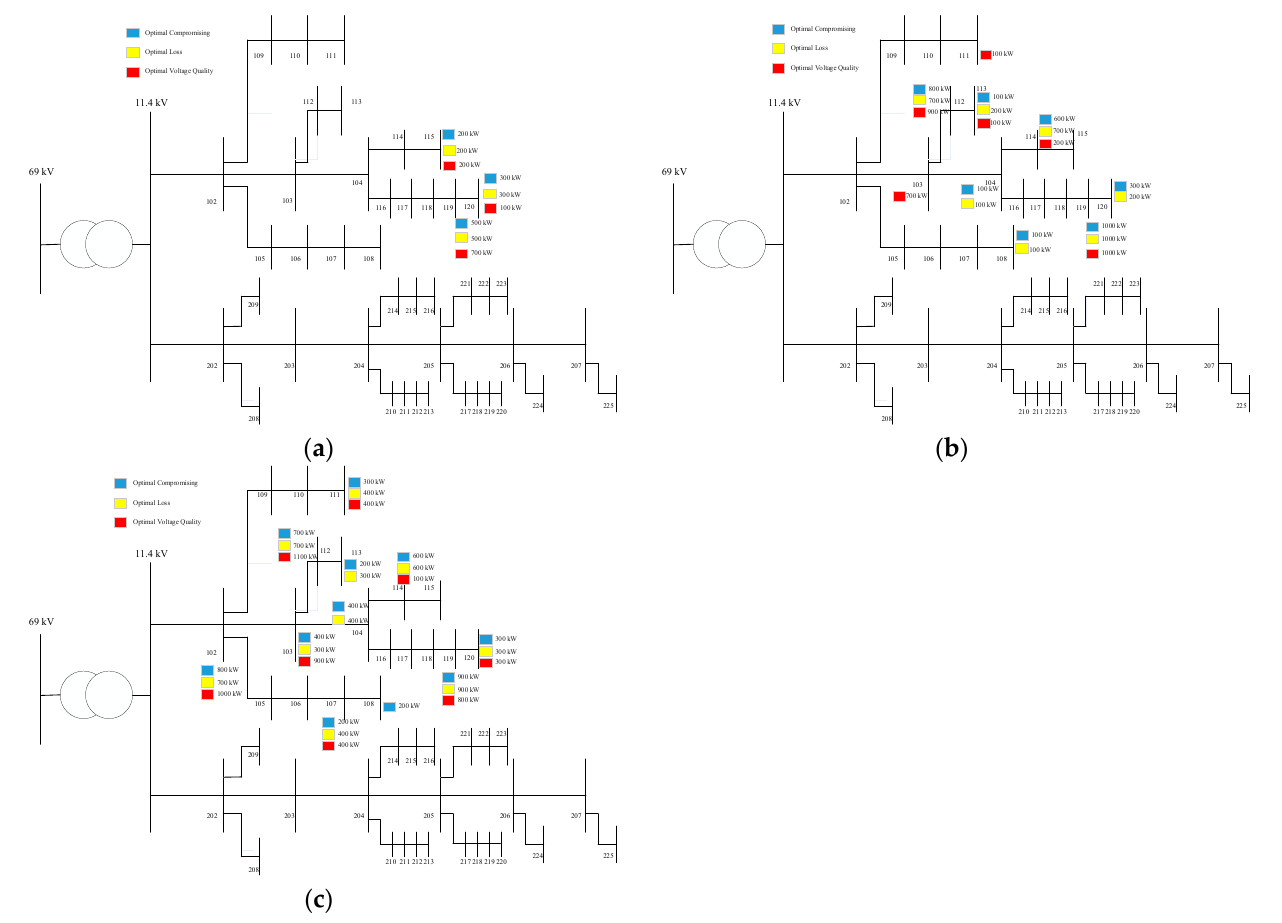
Figure 10. Optimal PV placements for Feeder1-Based simulation. ( a ) PV installed capacity 1000 kW; ( b ) PV installed capacity 3000 kW; ( c ) PV installed capacity 5000 kW. Table 4. Summary of the optimal PV placements of the Feeder1-Based model for different